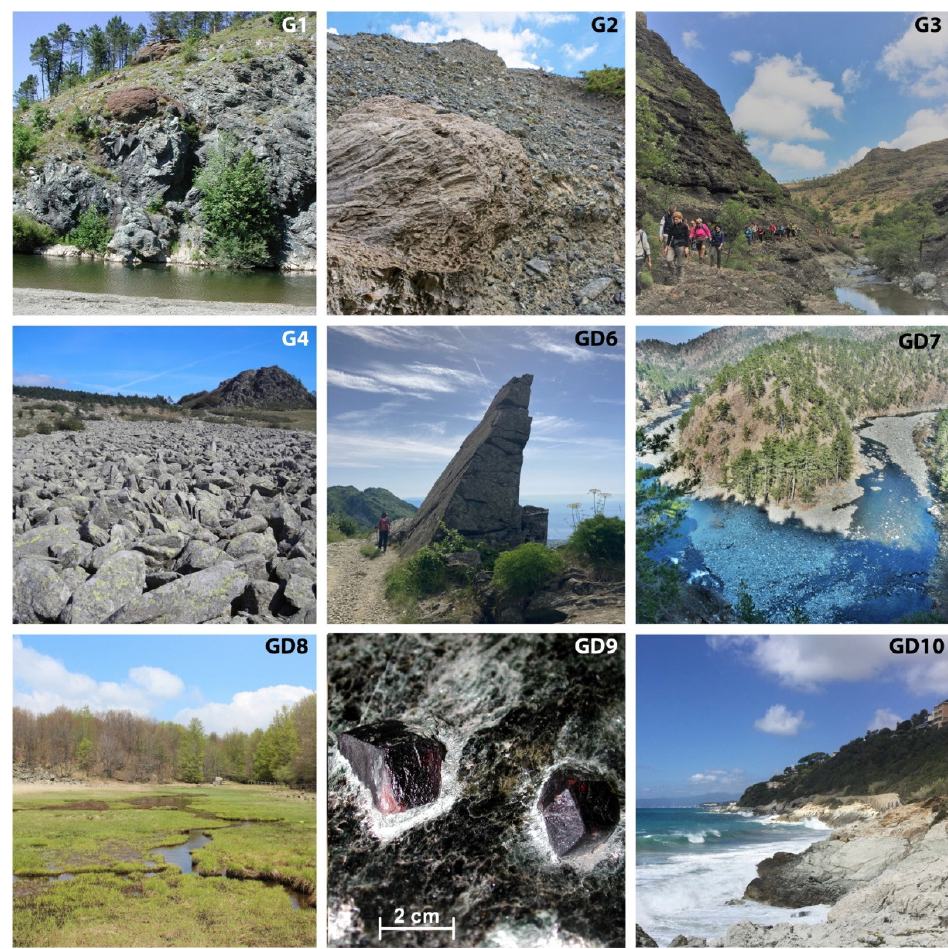
Figure 4. Selected views from the studied geosites. The geological features and other details of the sites are reported in Tables 1 and 2.